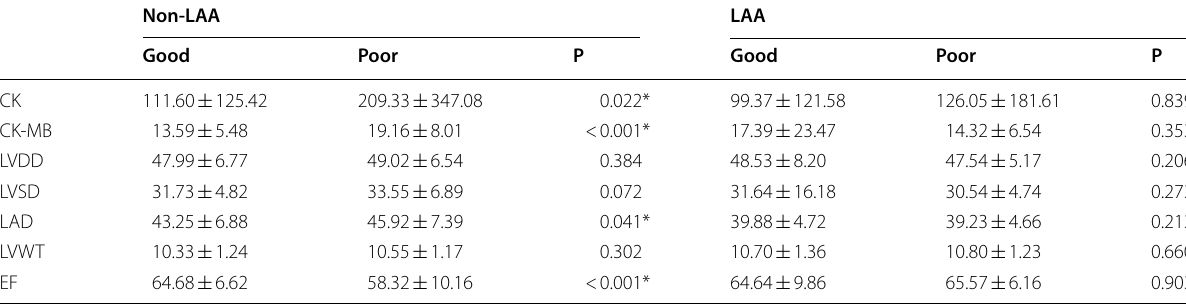
Table 2 Cardiogenic parameters of LAA and non-LAA type stroke Non‑LAA